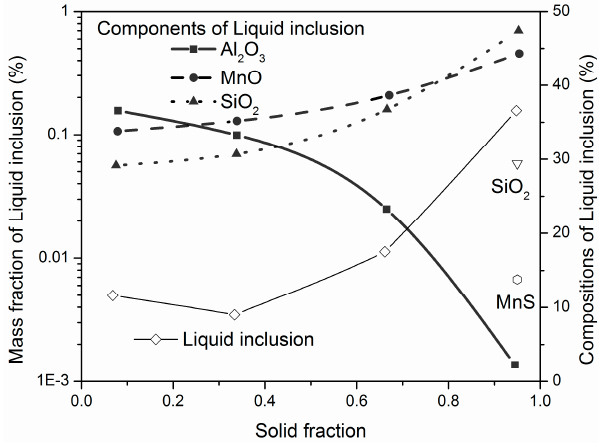
Figure 5. The results calculated by Choudhary and Ghosh [98].